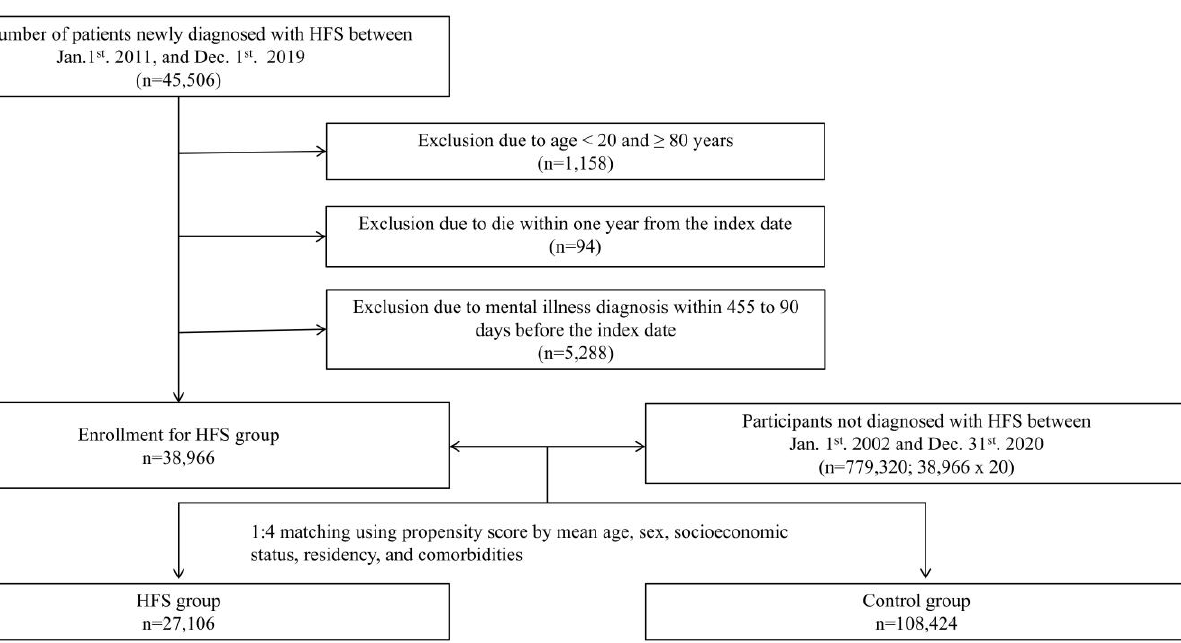
Figure 1. Schematic illustration of the participant selection from the Health Insurance Review and Assessment Service database of Korea.